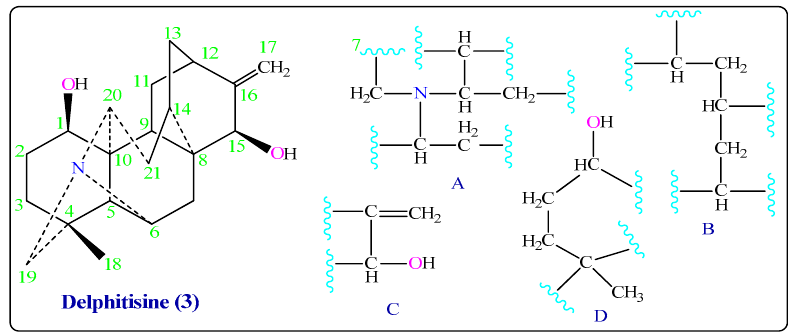
Figure 3. Partial structures of Delphitisine ( 3 ).